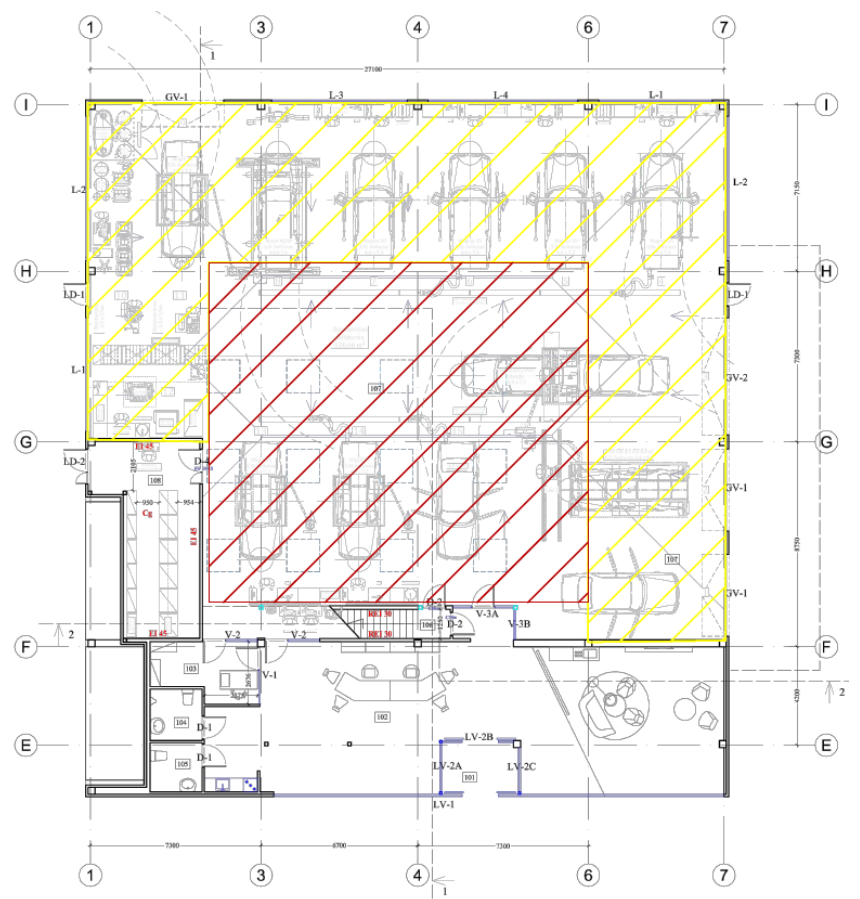
Figure 3. Distribution of natural light in the workshop: the area illuminated through the transparent façade envelope (marked in yellow) and the area illuminated through the skylights (marked in red). Where: the numbers indicate the coordination axes along the side of the building, while the letters indicate the coordination axes across the side of the building. The extension lines marked with a sign, which is an arrow with a shelf indicate elevation marks of levels (heights) of the building. Parameters used for the calculation of natural lighting are given in Table 3. Table 3. Parameters used for the calculation of natural lighting.